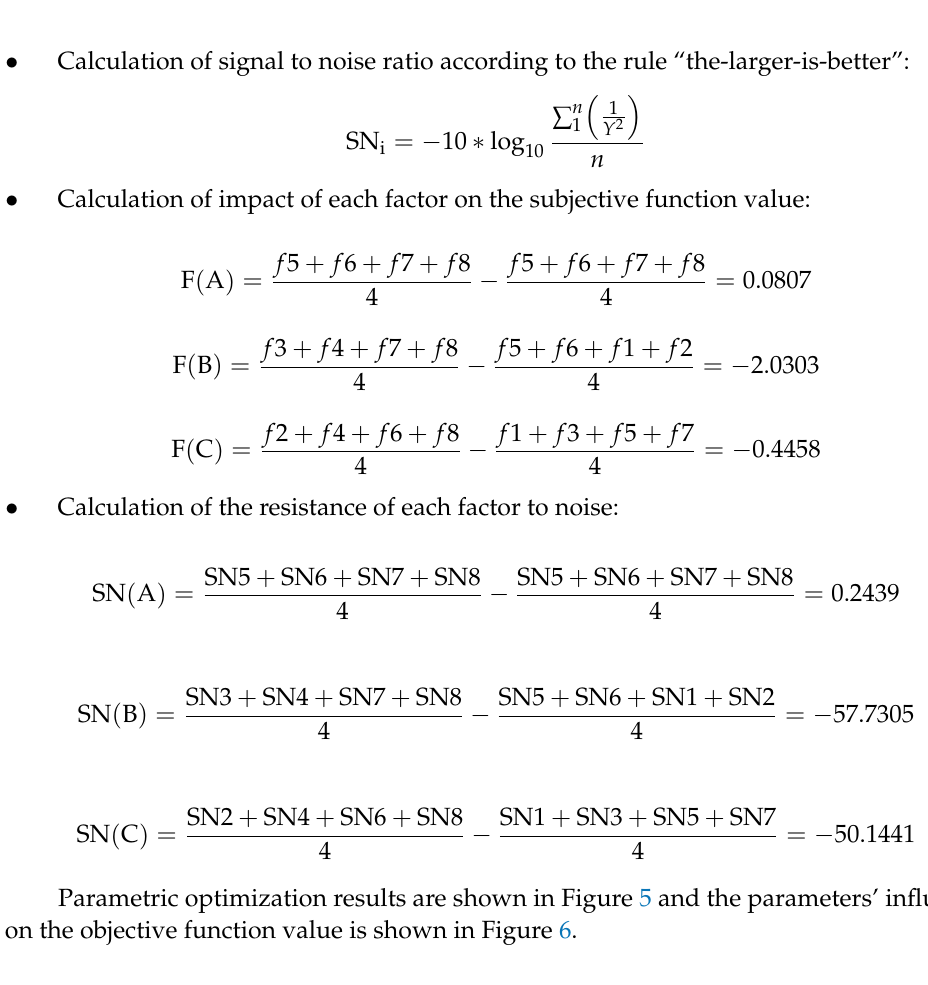
Figure 6. Parameters’ influence on the objective function value. The red points correspond to the values on the boundary conditions before averaging. 3.2. Features Extraction Individual model features were determined using MATLAB scripts to perform calculations on the .stl models. The first step was to center the data (3D points cloud) at zero. Next, the direction of most variance and rotation of the data was found to align it to